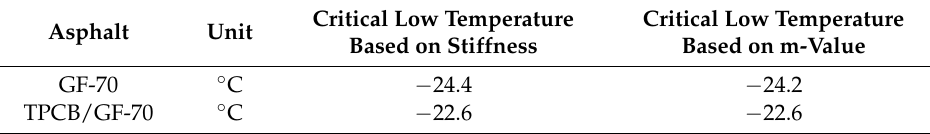
Table 5. Temperature of stiffness is 300 MPa and m-value is